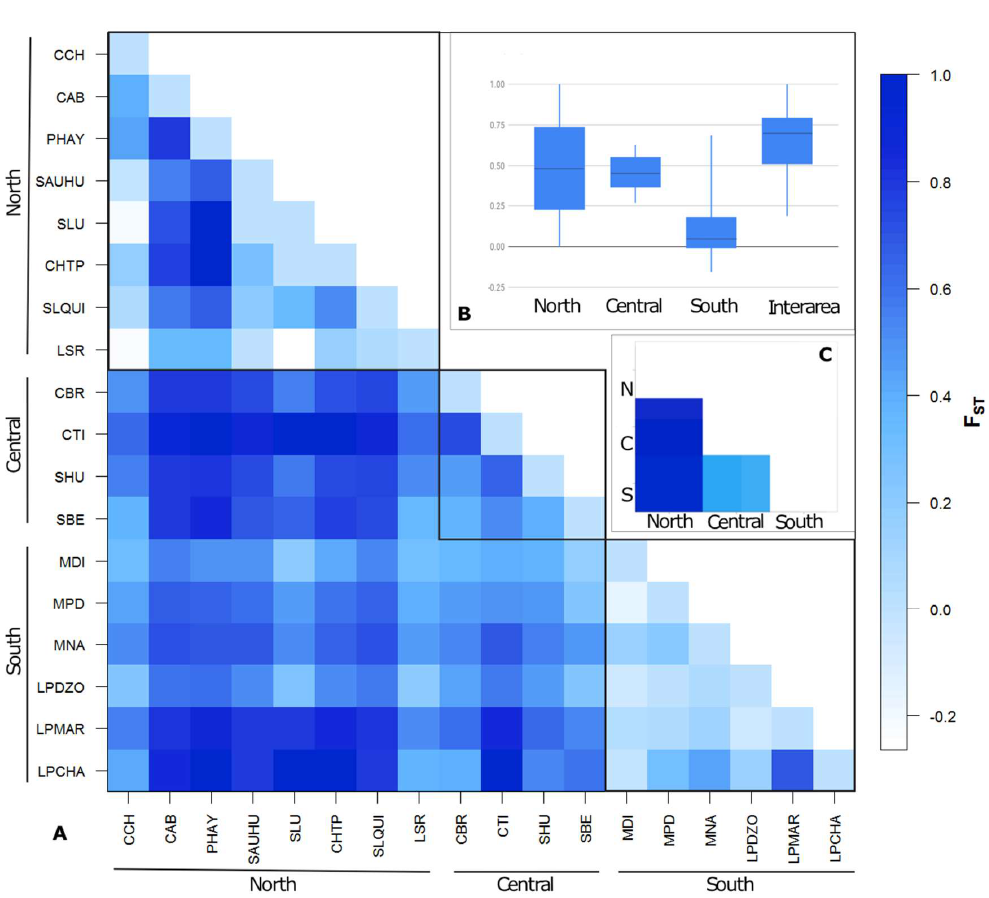
Figure 3. Genetic differentiation between localities and locality areas. ( A ) Graphical depiction of pairwise Fst values between individual localities; ( B ) Box plots contrasting the distribution of pairwise Fst values between localities within each locality area, and those between areas (interarea), horizontal bars represent mean values for each group; ( C ) Graphical depiction of pairwise Fst values between locality areas.